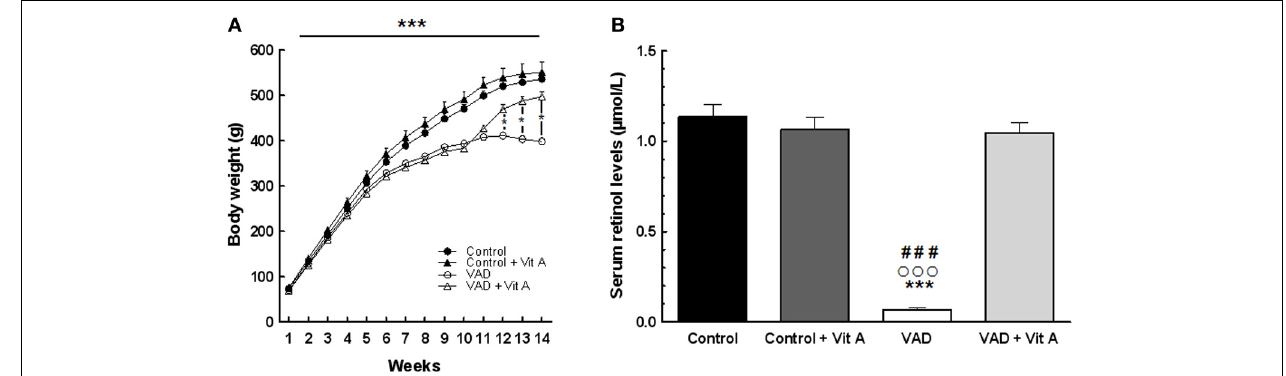
FIGURE 2 | Effects of 14 weeks of VAD and vitamin A supplementation on body weight gain (A) and serum retinol concentration (B). (A) The growth of the vitamin A deprived rats slows down after 10 weeks and reaches a plateau until the 14th week of VAD. This effect is counteracted by vitamin A